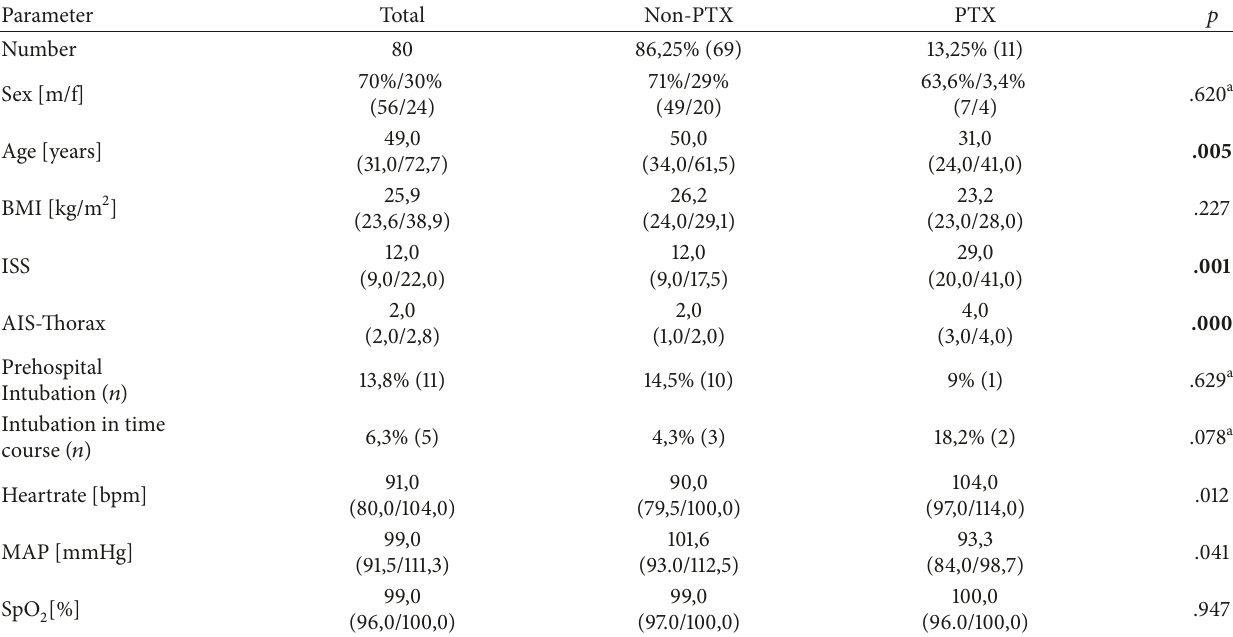
Figure 2: Results displayed by PneumoScan. Table 3: Patient characteristics . All parameters are presented in relative and absolute values, or as median with 25th/75th percentile. The significant 𝑝 value was calculated with Mann–Whitney 𝑈 Test. a Chi-Squared-Test. BMI: Body Mass Index; ISS: Injury Severity Score; AIS: Abbreviated Injury Scale; MAP: midarterial pressure; SpO 2 : peripheral oxygen